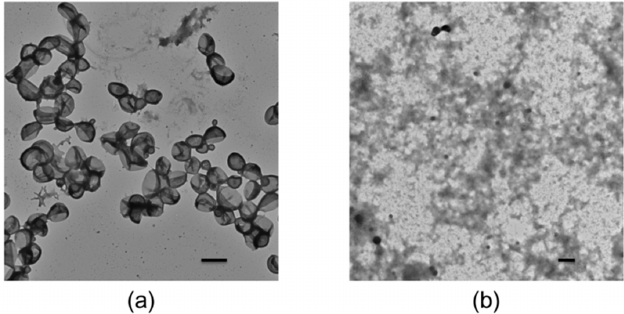
Figure 4. TEM characterizations of polymersomes ( a ) before and ( b ) after UV irradiation. The scale bars in the insets are 200 nm.